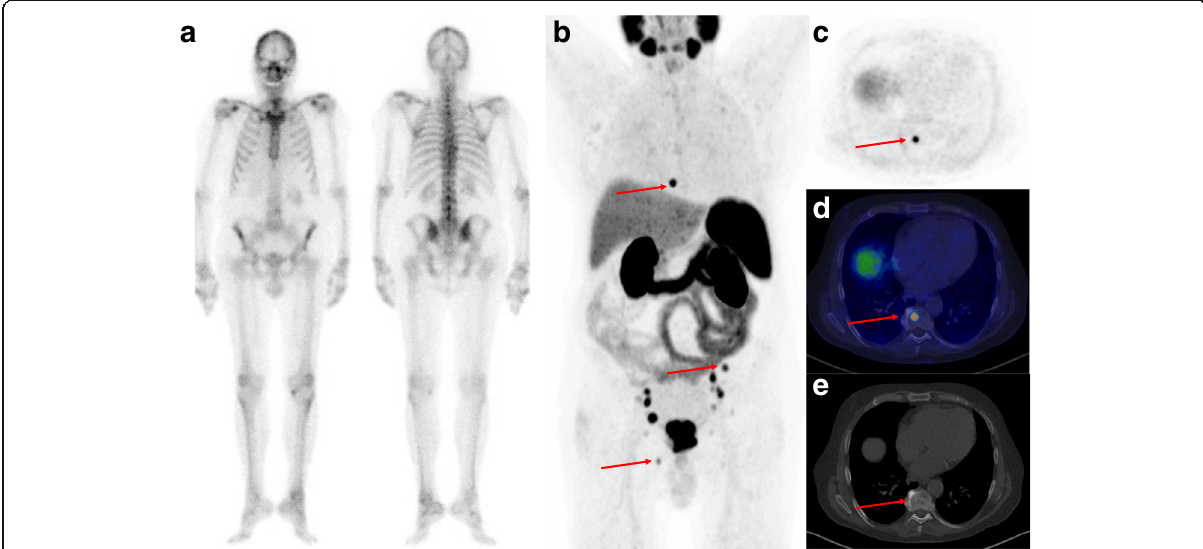
Fig. 1 Example of a patient (PSA 44 ng/mL, Gleason score 9, T3) classified as M0 according to initial BS as shown in anterior ( a ) and posterior projection ( b ). The patient was referred for 68 Ga-PSMA-11 PET/CT due to high-risk prostate cancer. The maximum intensity projection (MIP) of the 68 Ga-PSMA-11 PET ( c ) revealed several lesions with avid 68 Ga-PSMA-11 uptake, including three bone metastases marked with arrows (Th8, left iliac bone and right pubic bone). The axial 68 Ga-PSMA-11 PET image of the lesion in Th8 is shown in c with a fused 68 Ga-PSMA-11 PET/CT image shown in d and only a slight sclerotic change in the axial CT image ( e ). BVC confirmed M1